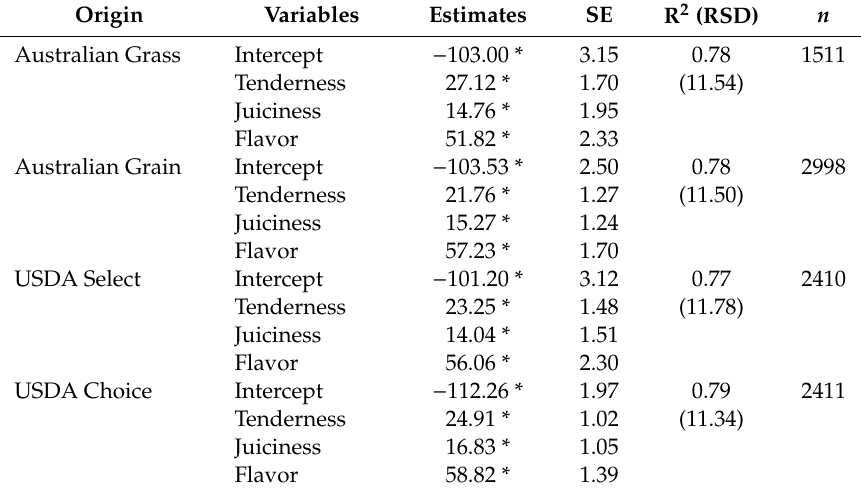
Table 4. Comparisons of origins and attribute e ff